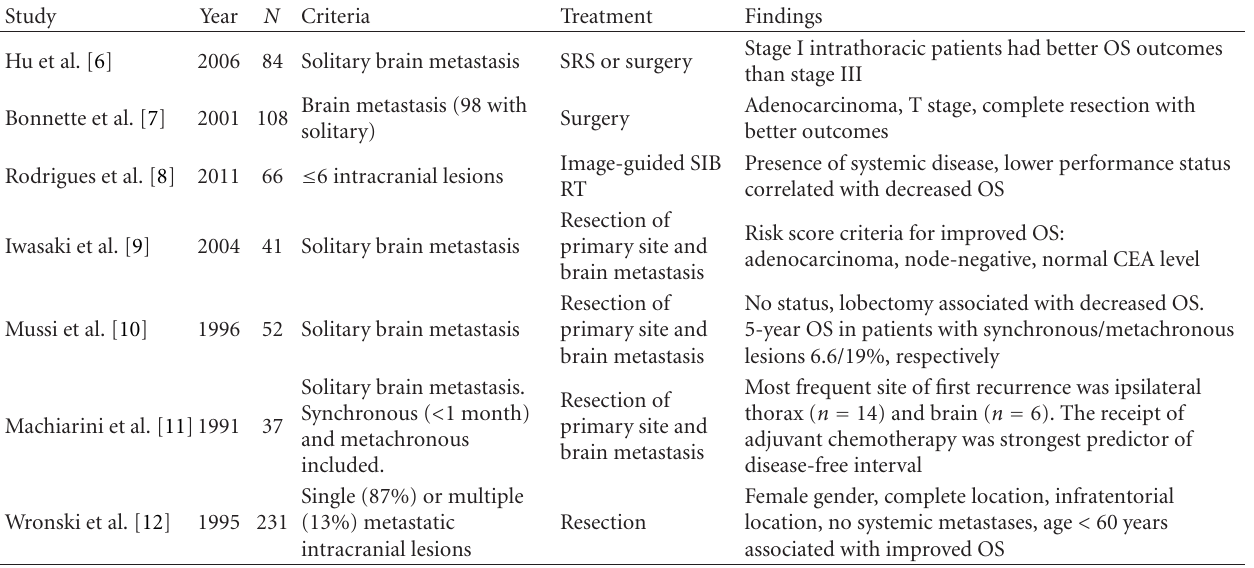
Table 1: Selected studies of local treatment in oligometastatic NSCLC with brain